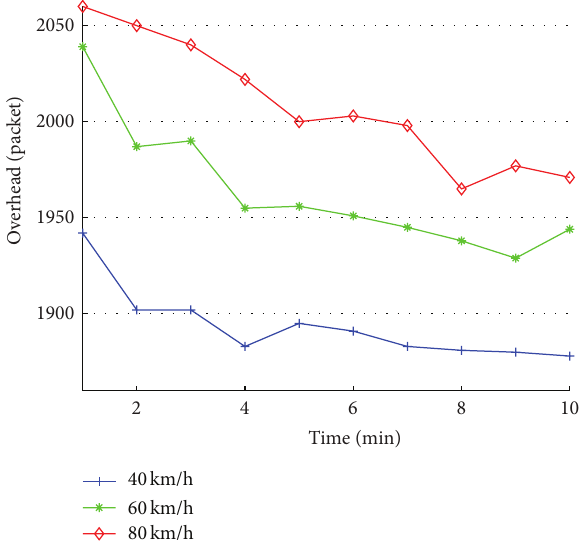
Figure 4: The impact of node’s moving speed on the amount of switching packets of entire network.